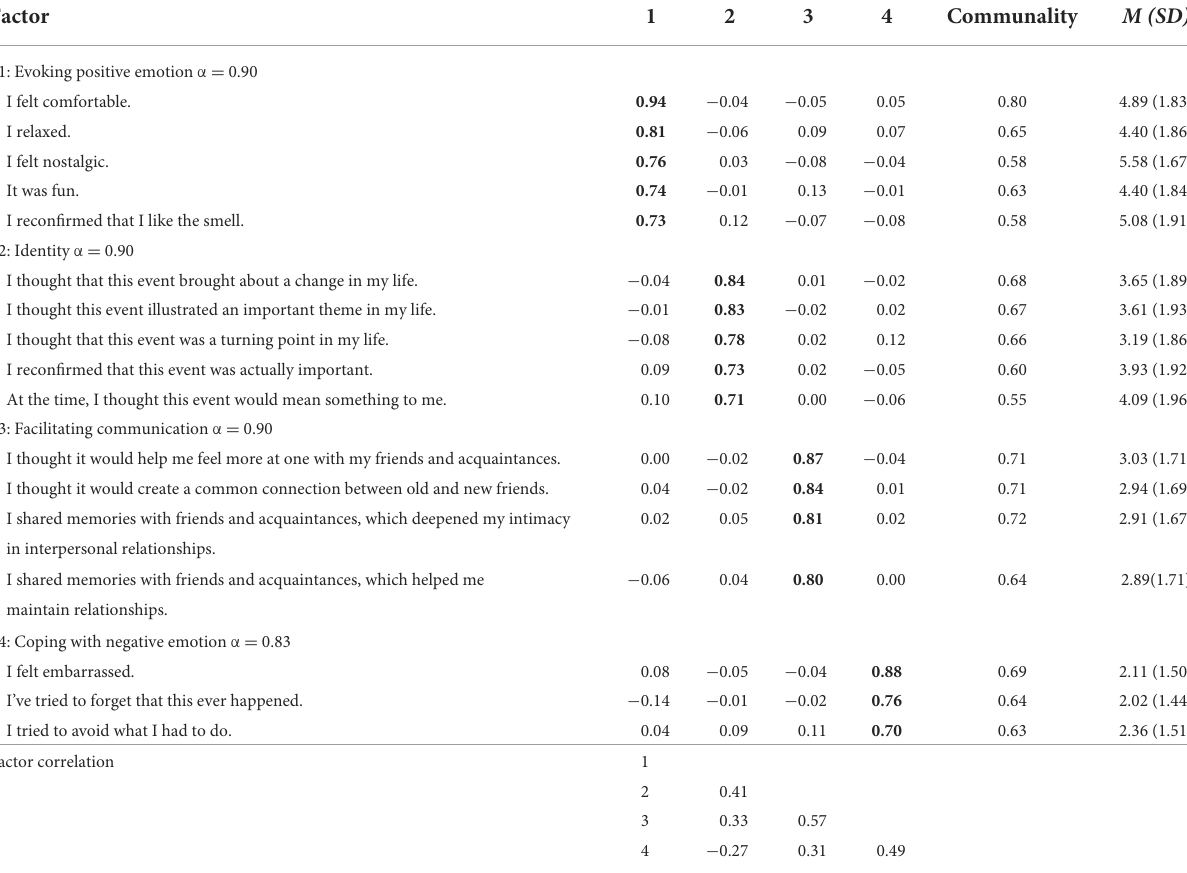
TABLE 1 The results of factor analysis of the FAMOS. Factor 1